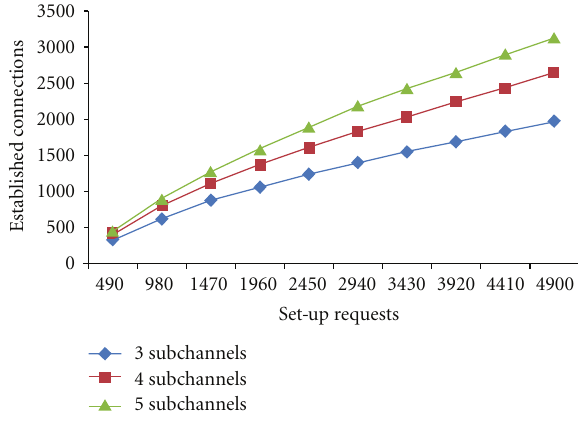
Figure 26: Established connections in 7 × 7 TDM